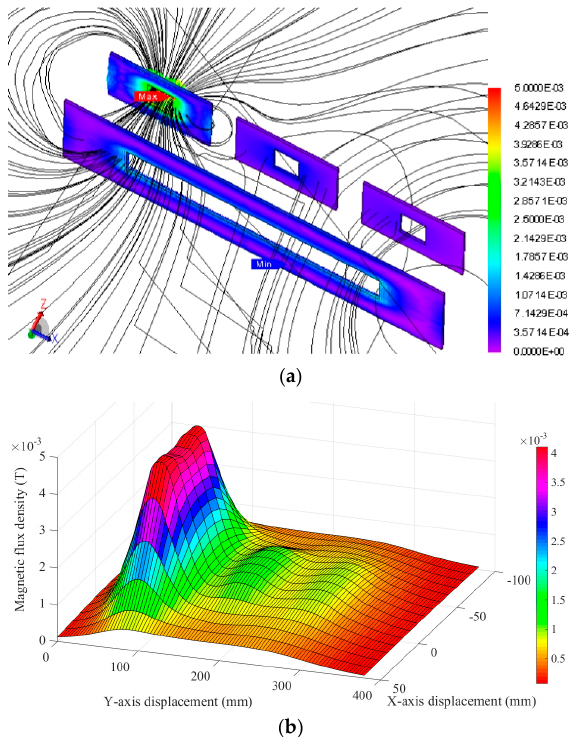
Figure 3. Electromagnetic field analysis at resonant frequency of 60 kHz: ( a ) magnetic flux line distribution; and ( b ) magnetic flux density distribution.